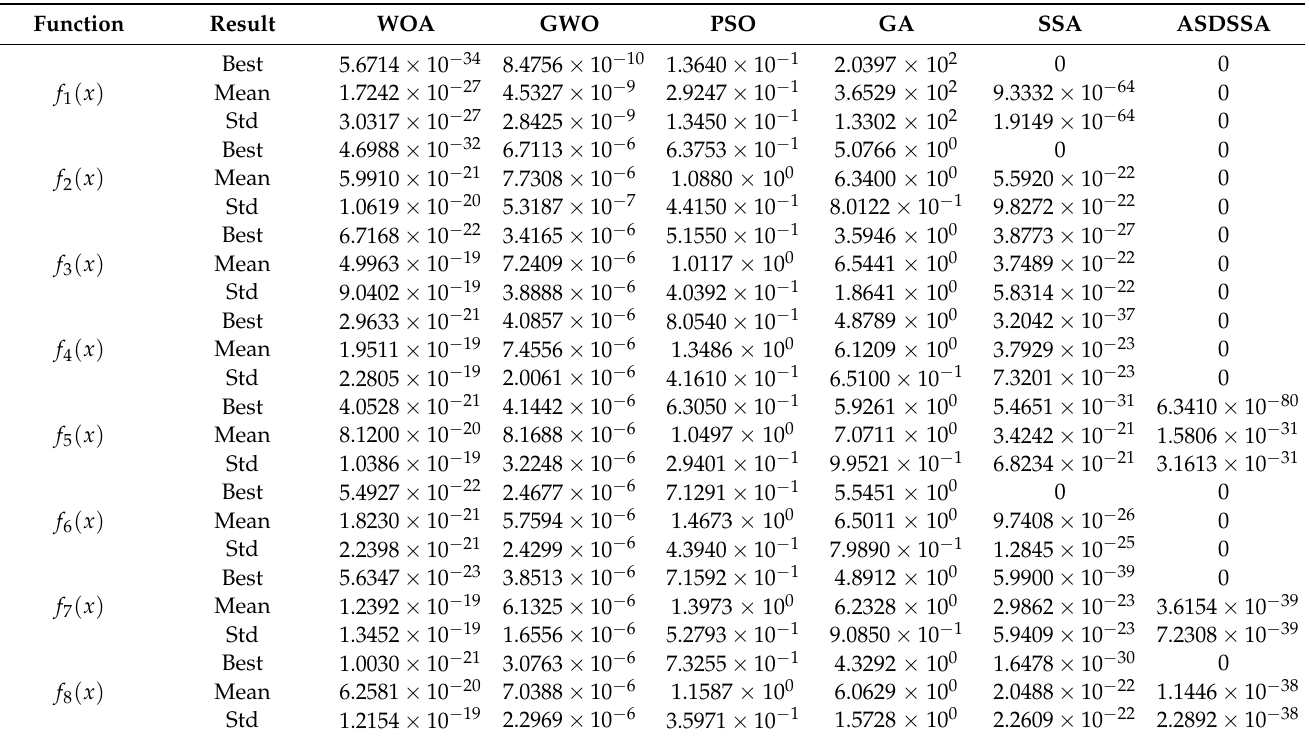
Table 3. Comparison of the benchmark test function optimization